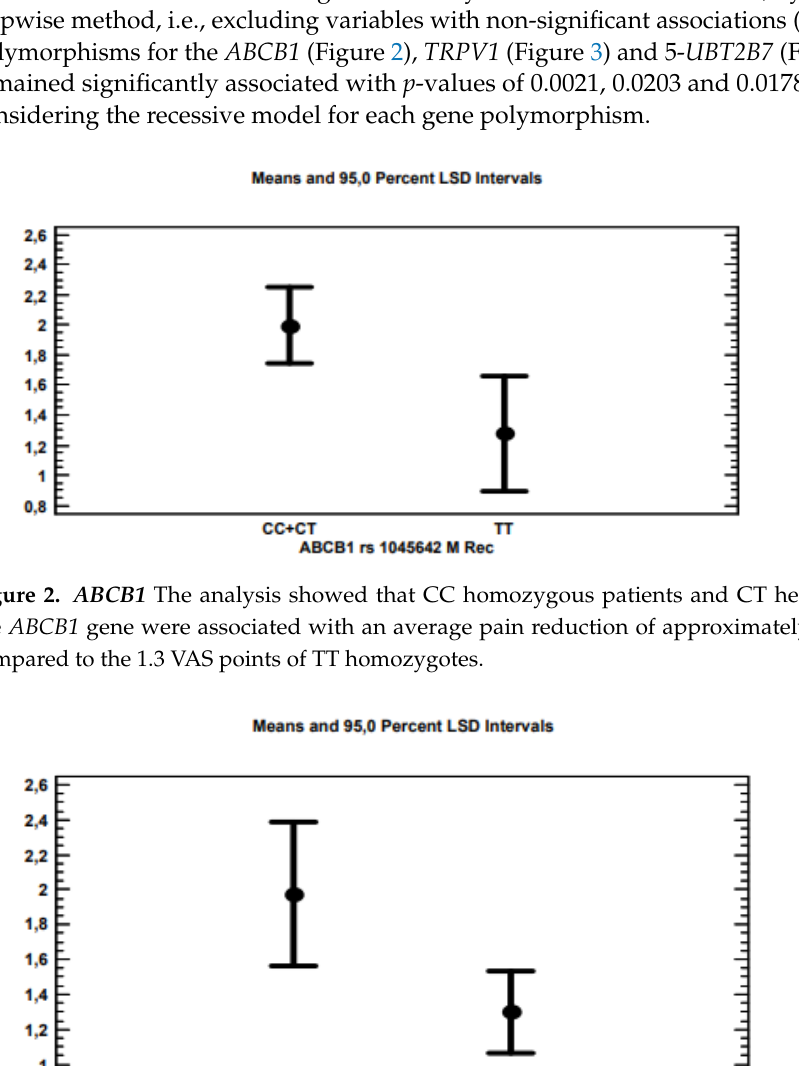
Figure 4. UBT2B7 AA homozygous patients for the UGT2B7 gene reported an average pain decrease of 2 VAS points, compared to the 1.3 VAS points of GG homozygotes or AG heterozygotes. Because the three genes did not show interactions and each patient was simultane- ously characterized by the three polymorphisms of the three genes, to explore a possible polygenic effect, patients were grouped according to the eight possible combinations of polymorphisms, as reported in Table 2. Furthermore, our results showed that the three polymorphisms associated with the greatest decrease in pain were, respectively, CC+CT for ABCB1 , CC for TRPV1 and AA for 5-UGT2B7 . In Table 2, the eight combinations were, therefore, ordered according to the number of polymorphisms, which favoured a greater decrease in pain.